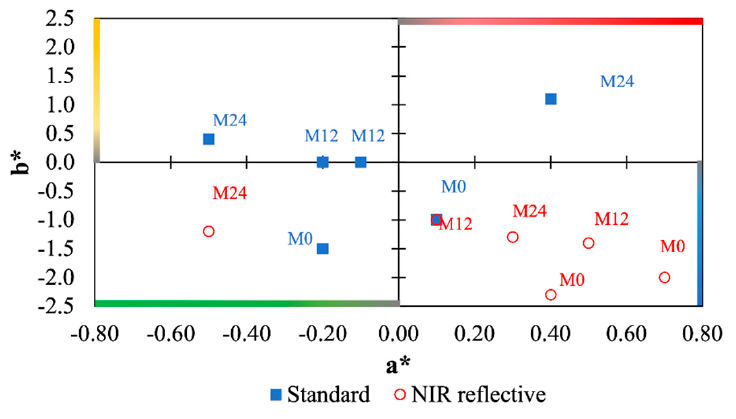
Figure 3. Chroma coordinates.